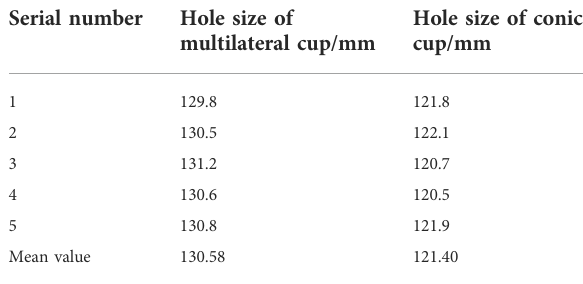
TABLE 10 Plastic fi lm hole size (planting frequency of 72 plants/